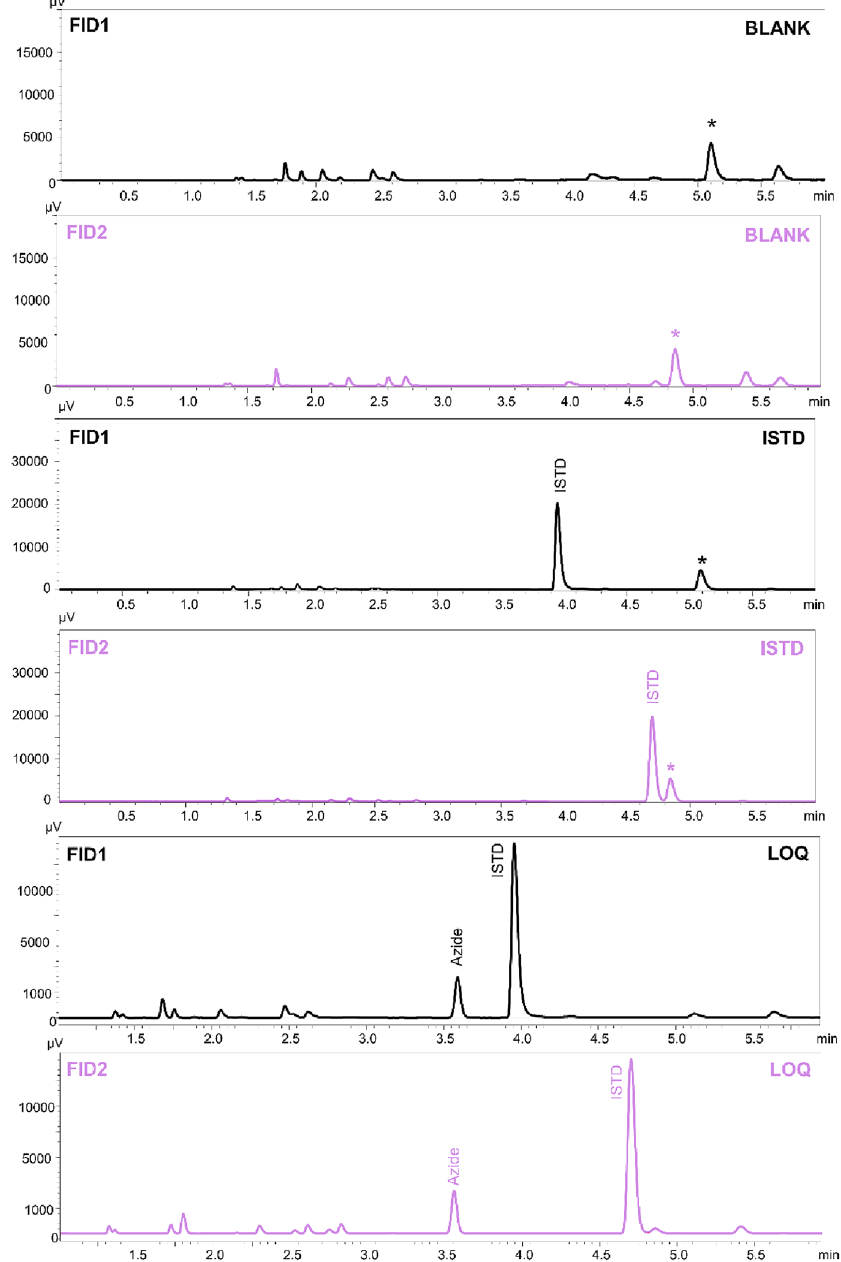
Figure 2. Chromatograms of blank blood sample, ISTD, and azide at concentration of LOQ with ISTD. The unreacted derivatization reagent (propionic anhydride) has been marked with an asterisk. The black line illustrates the results from FID1 and the violet line from